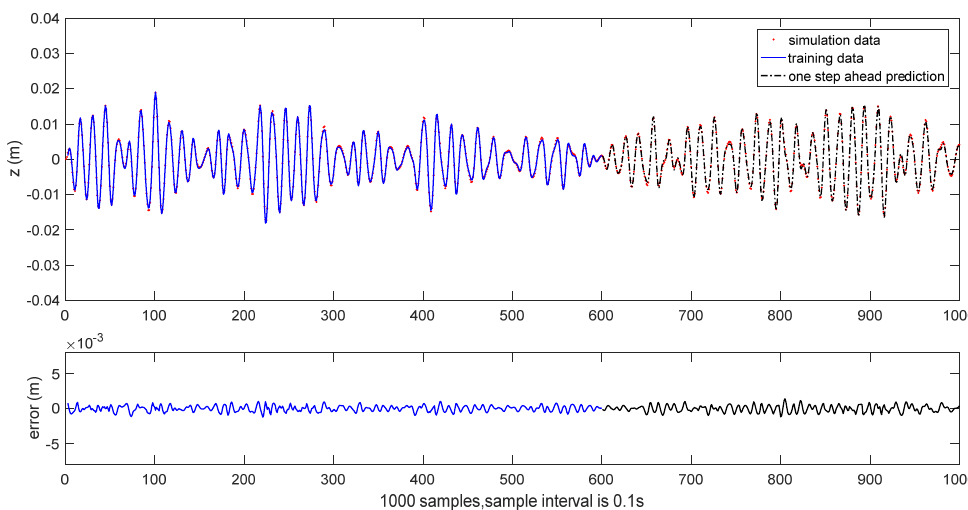
Figure 4. The one-step-ahead prediction of heave motion in irregular waves for the R-Class Icebreaker model.